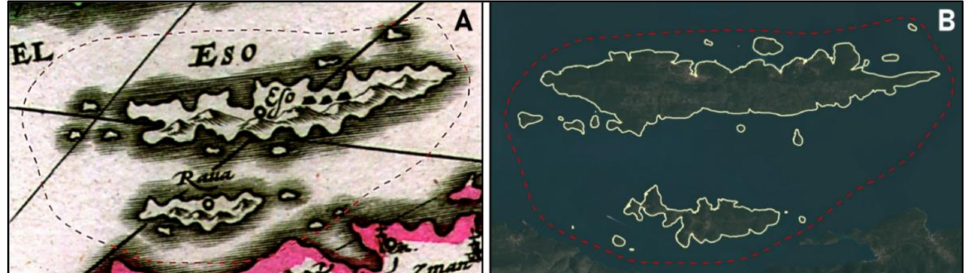
Figure 1. Coastal paradox demonstrated by the representation of Iž-Rava island group in Janszoon’s Map of Northern Dalmatia, Amsterdam, c. 1620 [Jan Janszoon, Iadera sicum et Aenona vulgo Zara, Sebenico et Nona cum insulis adjacentibus in parte Dalmatiae boreali , Amsterdam, c. 1620 (National and University Library, Zagreb, Map and Atlas Collection, Novak Collection, Call number ZN-Z-XVII- JAN-1620b)] ( A ) and Worldview imagery, 2016 ( B